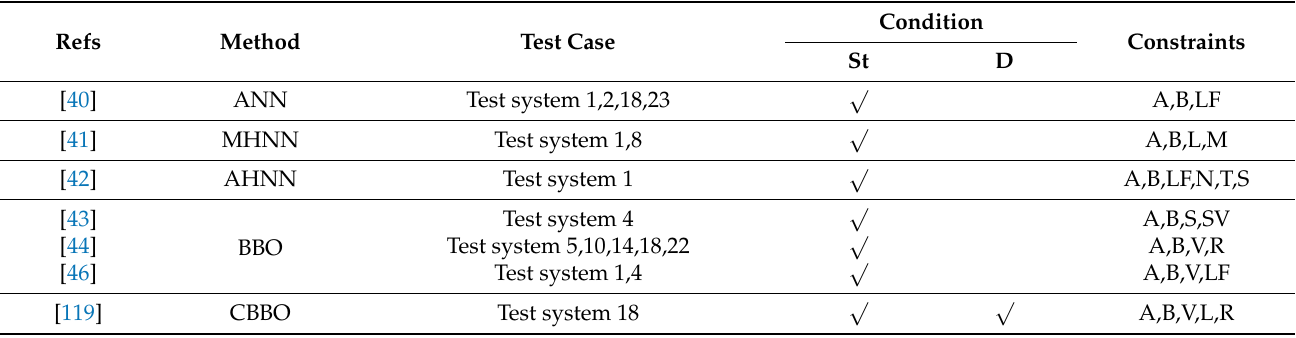
Table 3. Summary of nonconventional methods related to CEED